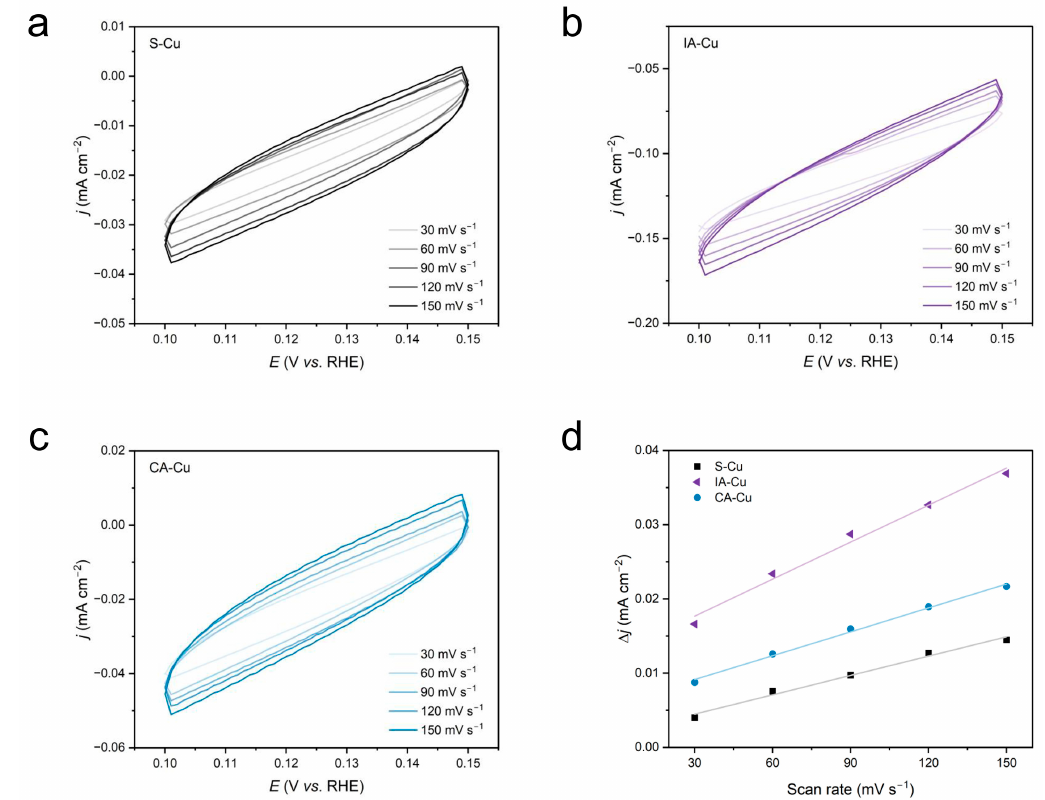
Figure 3. CV curves of samples S-Cu ( a ), IA-Cu ( b ), and CA-Cu ( c ). ( d ) Non-Faradaic current density ( Δ j ) as a function of scan rate (mV s − 1 ) of the electrode (slopes corresponding to the DLC values).